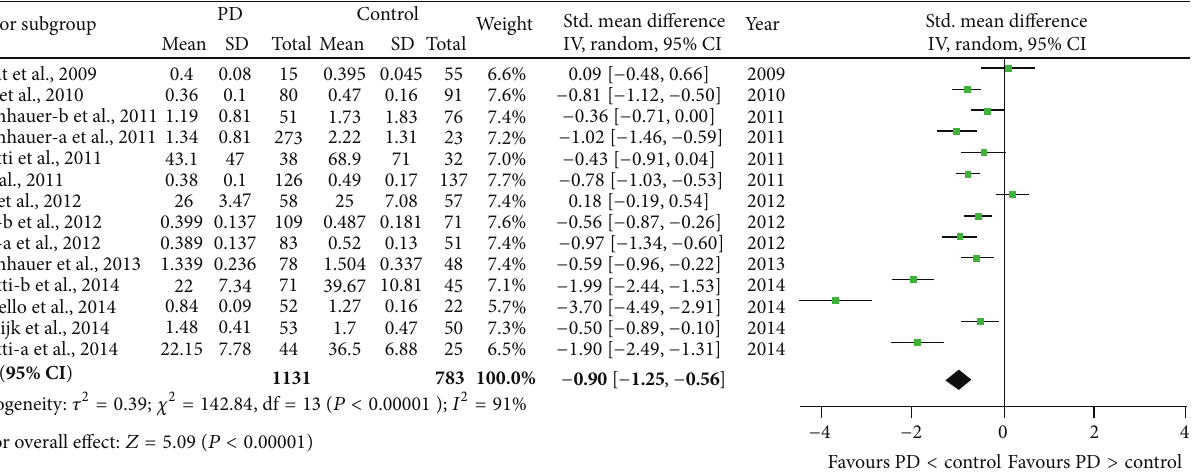
Figure 3: Forest plot of CSF 𝛼 -syn levels in PD compared to controls.